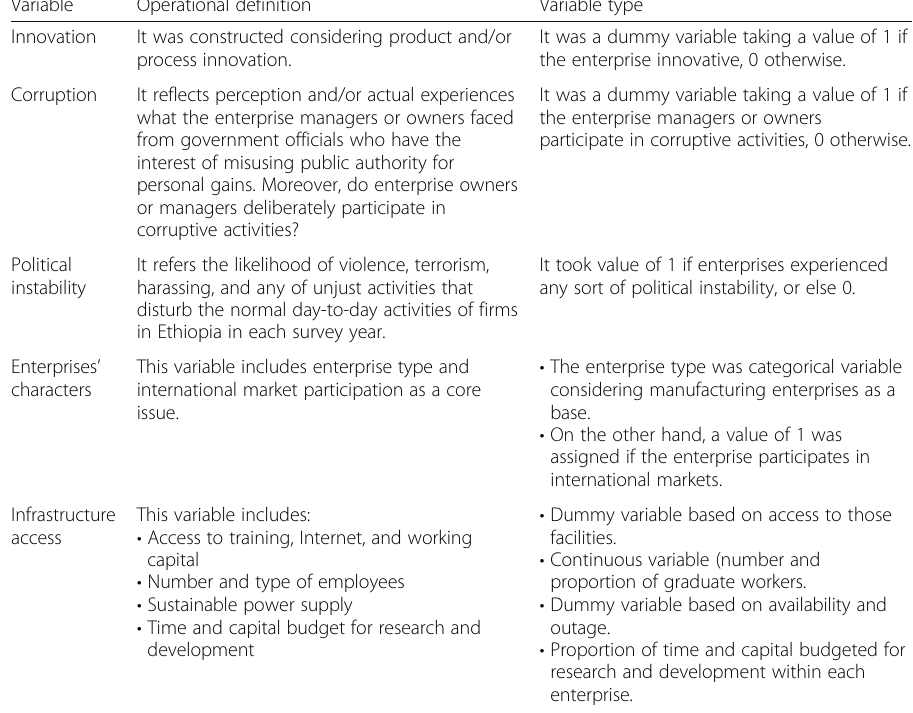
Table 1 Definition of basic variables